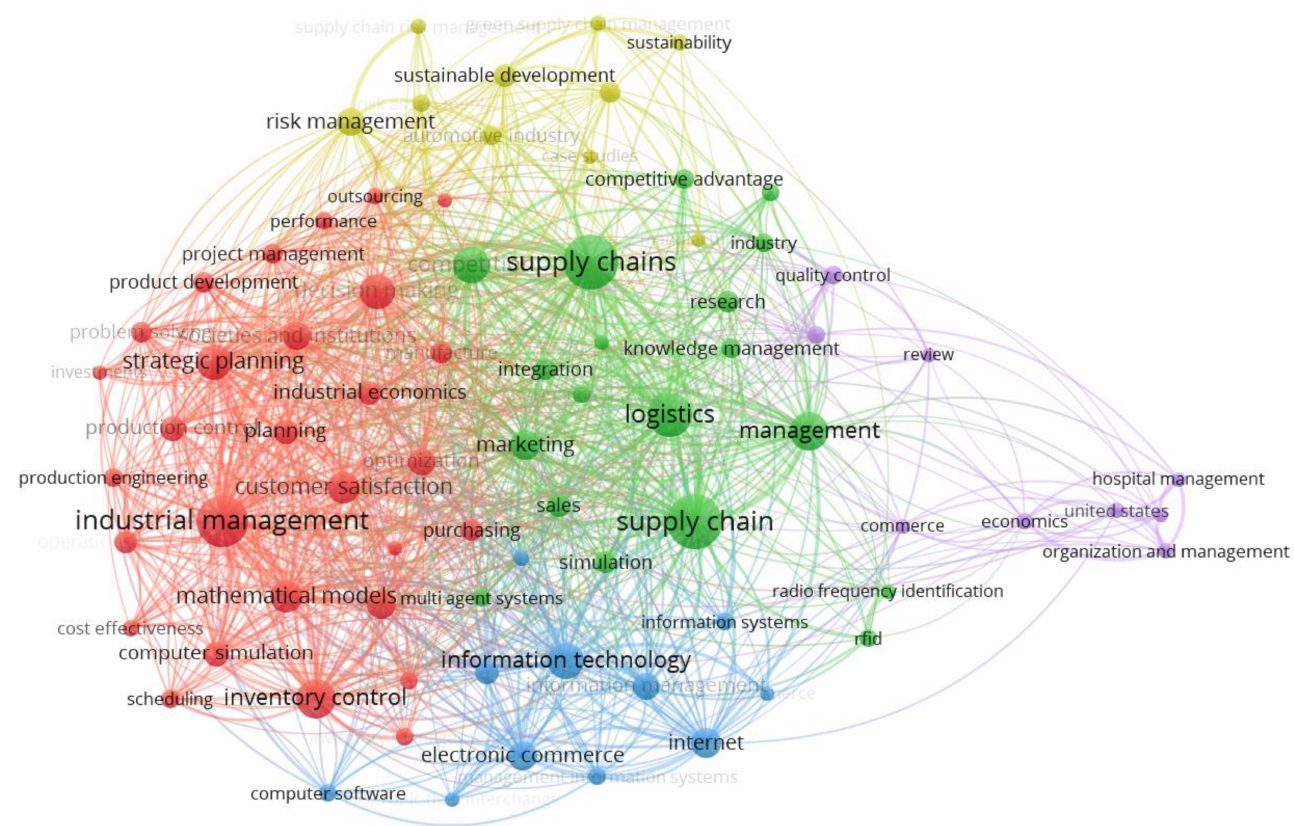
Figure 4. Keyword co-occurrence network regarding SCM between 1990 and